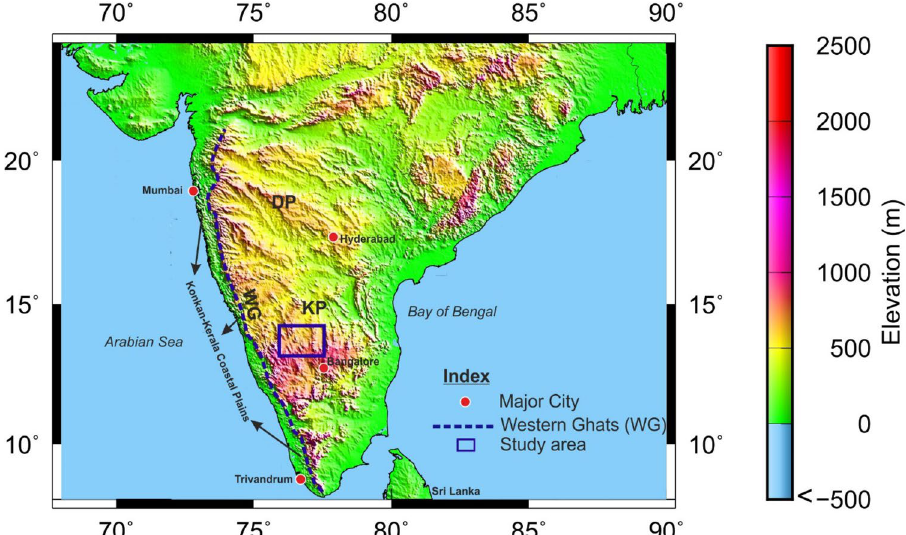
Figure 2. The elevation map of the Karnataka plateau and adjoining regions of southern India plotted using Generic Mapping Tools (GMT) (after Wessel et al. 12 ), a free software. Elevation data (after Smith et al. 13 ) is downloaded from https ://topex .ucsd.edu/cgi-bin/get_data.cgi. N–S dashed line represents the Western Ghats (WG). KP Karnataka Plateau, DP Deccan